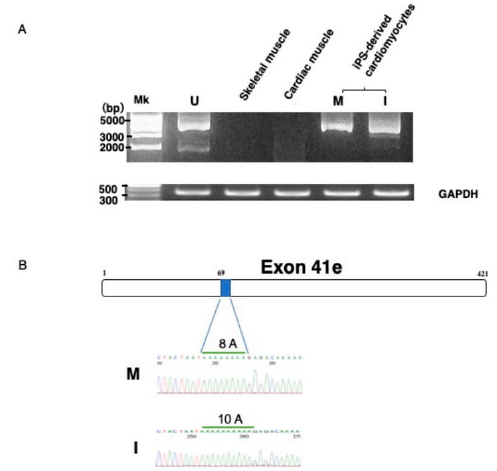
Figure 2. Identification of the novel transcript. ( A ) Amplification of the novel transcript. PCR amplification of the full-length transcript was conducted using a forward primer on exon M1 and a reverse primer on intron 41 (exon 41e). The PCR amplified product of U-251 cDNA was about 5 kbp in size (U). RT-PCR showed that the novel transcript was not expressed by Dp427m expressing skeletal (S) and cardiac (C) muscle tissues. In contrast, amplified products were obtained from iPS- derived MiraCell ® cardiomyocytes (M) and iCell ® cardiomyocytes 2 (I). The quality of the prepared cDNA was examined by amplifying GAPDH mRNA, yielding a product of expected size obtained from all cDNAs. ( B ) Nucleotide sequences of exon 41e. A part of nucleotide sequences of exon 41e from MiraCell ® cardiomyocytes and iCell ® cardiomyocytes 2 is shown (lower). Sequencing of their